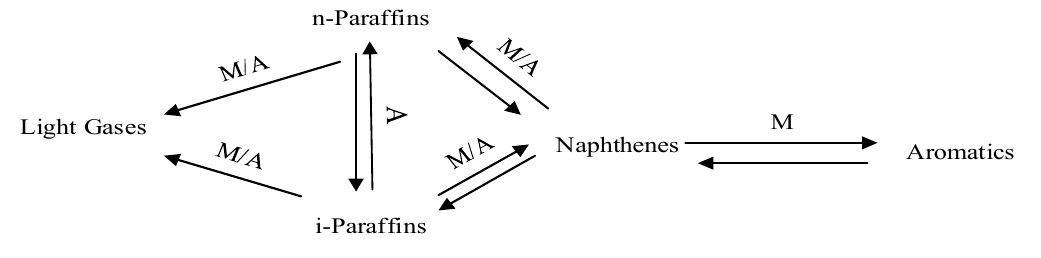
Figure 1. Network of Reforming Reactions.